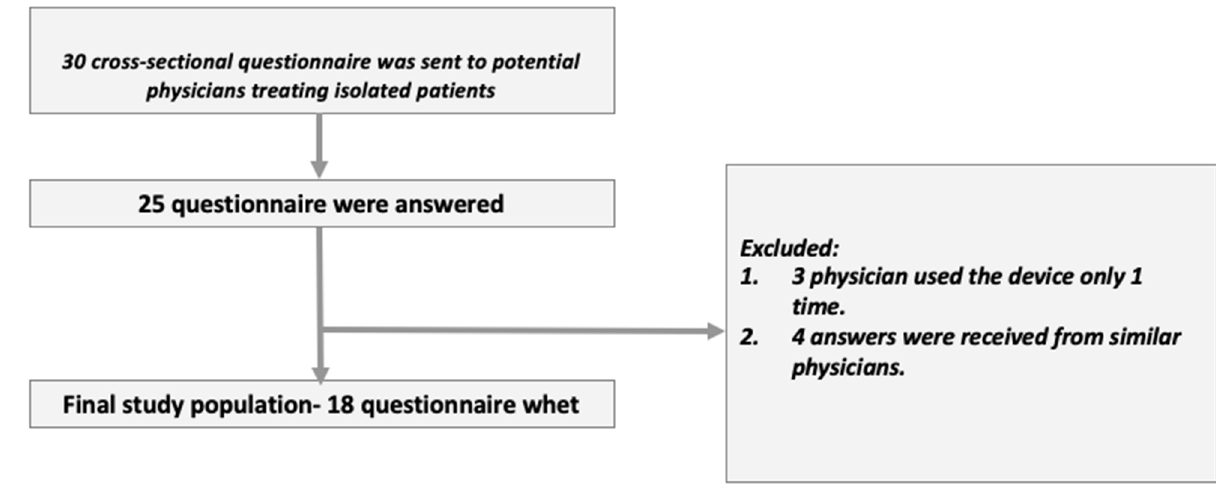
Figure 2. Study Figure 2. Study flow.